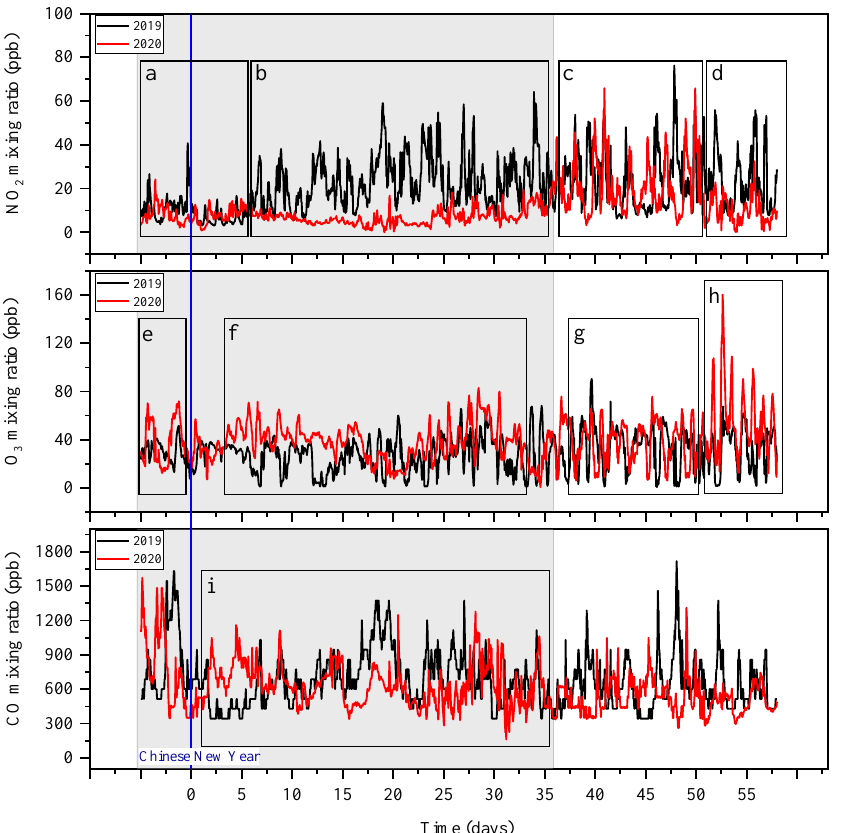
Figure 5. Comparison of temporal variations of the concentrations of NO 2 , O 3 and CO between 2020 and 2019. The Chinese New Year in the figure refers to 2020 and 2019, which are compared according to the Chinese lunar period. The x-axis is the number of days relative to the Chinese New Year. The data depicted by the black line in 2019 come from the reference apparatus, and the data depicted by the red line in 2020 come from the sensor package. The shaded area shows the period during the lockdown. ( a ) The NO 2 concentration decreased slightly at the beginning of the lockdown; ( b ) Five to 35 days after the Chinese New Year, the highest concentration of NO 2 was equal to the lowest level of the previous year; ( c ) The NO 2 concentration increased significantly and reached the same level as the previous year; ( d ) In Figure 5h, the concentration of O 3 increased significantly and the corresponding NO 2 concentration was low; ( e ) When the lockdown was first implemented, the O 3 concentration increased from 0 to 15 ppb; ( f ) Starting from 3 days after the Chinese New Year, the O 3 concentration increased compared with that of the previous year and reached the maximum difference of 62 ppb after 7 days of the Chinese New Year; ( g ) After the lockdown, the O 3 concentration was almost the same as that of the previous year; ( h ) Until 51 days after the Chinese New Year, the O 3 concentration increased significantly; ( i ) After the Chinese New Year of 2019, the concentration of CO showed a rising trend. During the lockdown in 2020, the concentration of CO showed a declining trend.